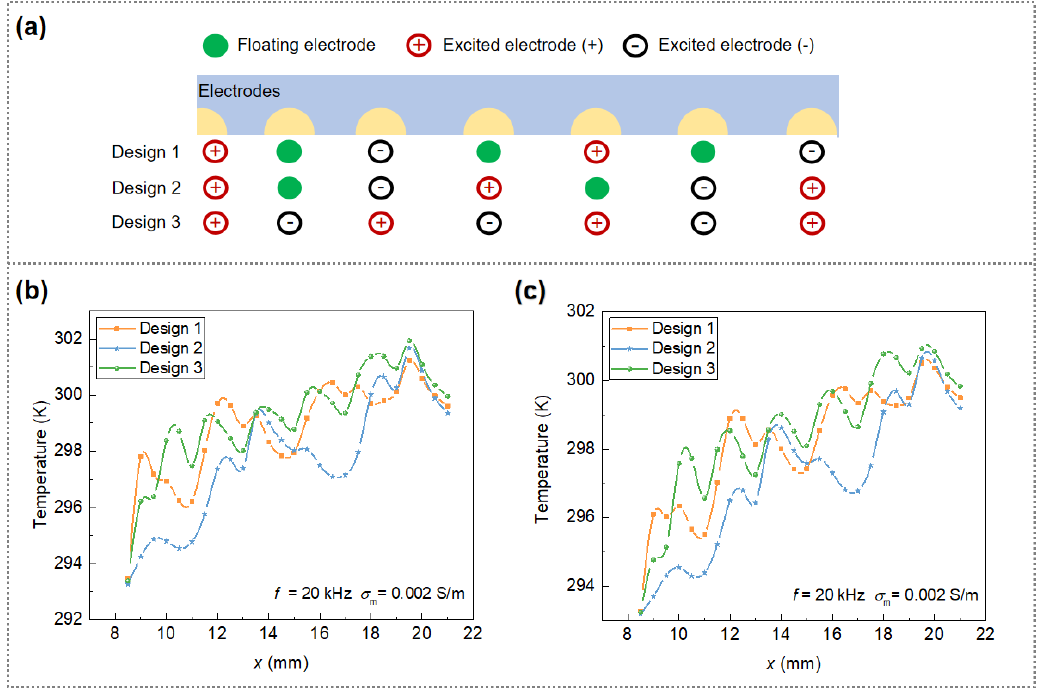
Figure 5. ( a ) Design strategies of the floating electrode arrangement; temperature profile at ( b ) y = 0.1 mm and ( c ) y = 0.2 mm for three different electrode designs.